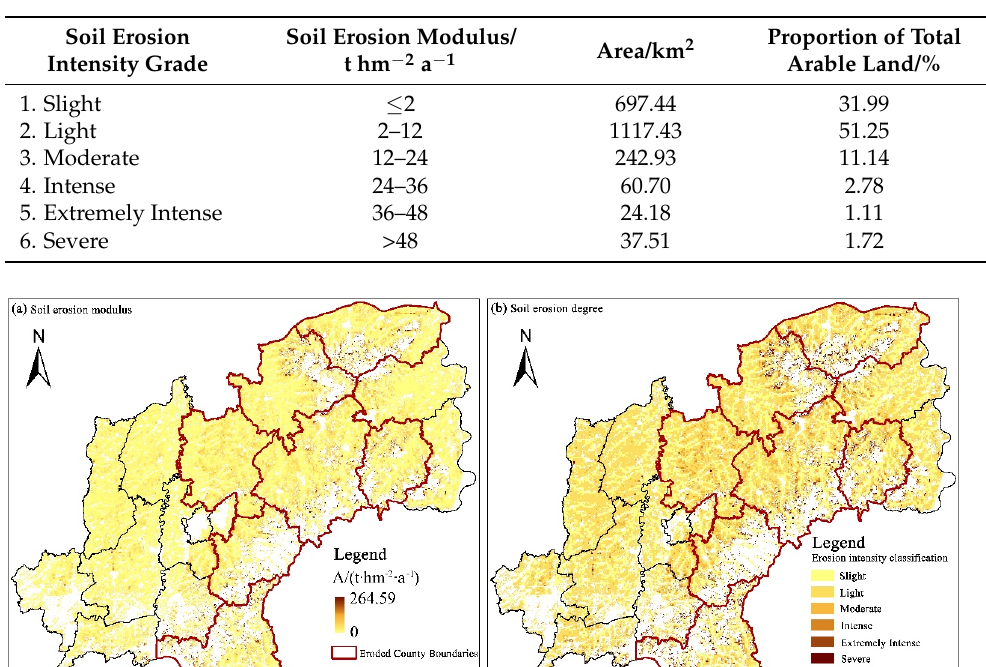
Table 2. Statistical results of different soil erosion intensities of cropland.